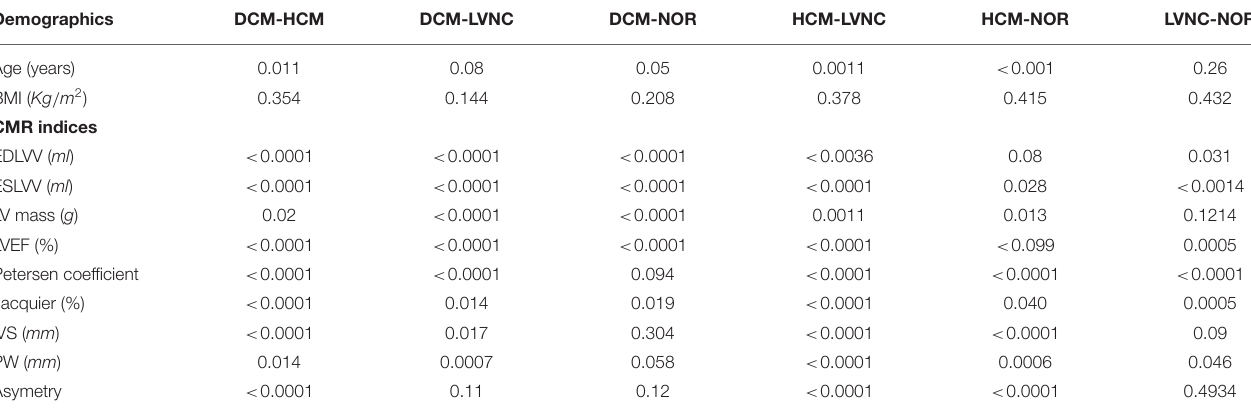
TABLE 3 | Mann Whitney U statistical test for demographics and clinical characteristics group